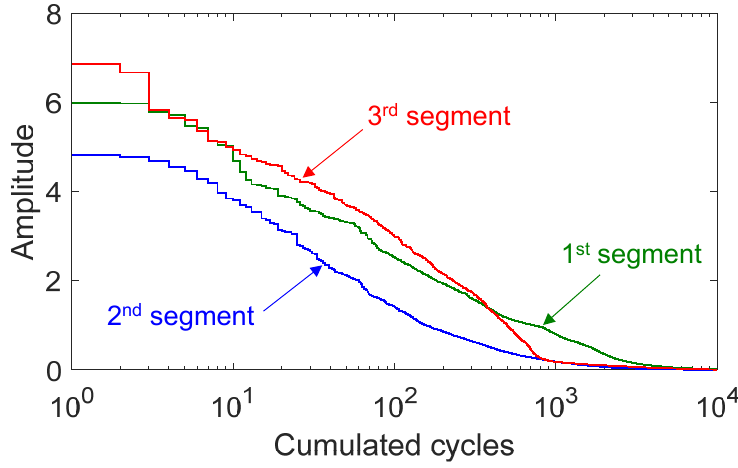
Figure 8. Comparison of cumulative spectra from three segments of z ( t ) of same duration T s = 853.3 s each (CH6 record, outer rim). Amplitude is normalized to signal standard deviation.